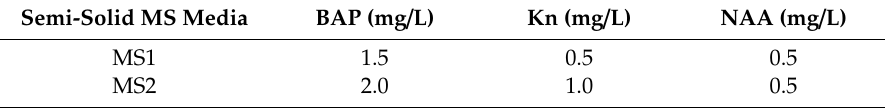
Table 4. MS media supplemented with combinations of PGR for